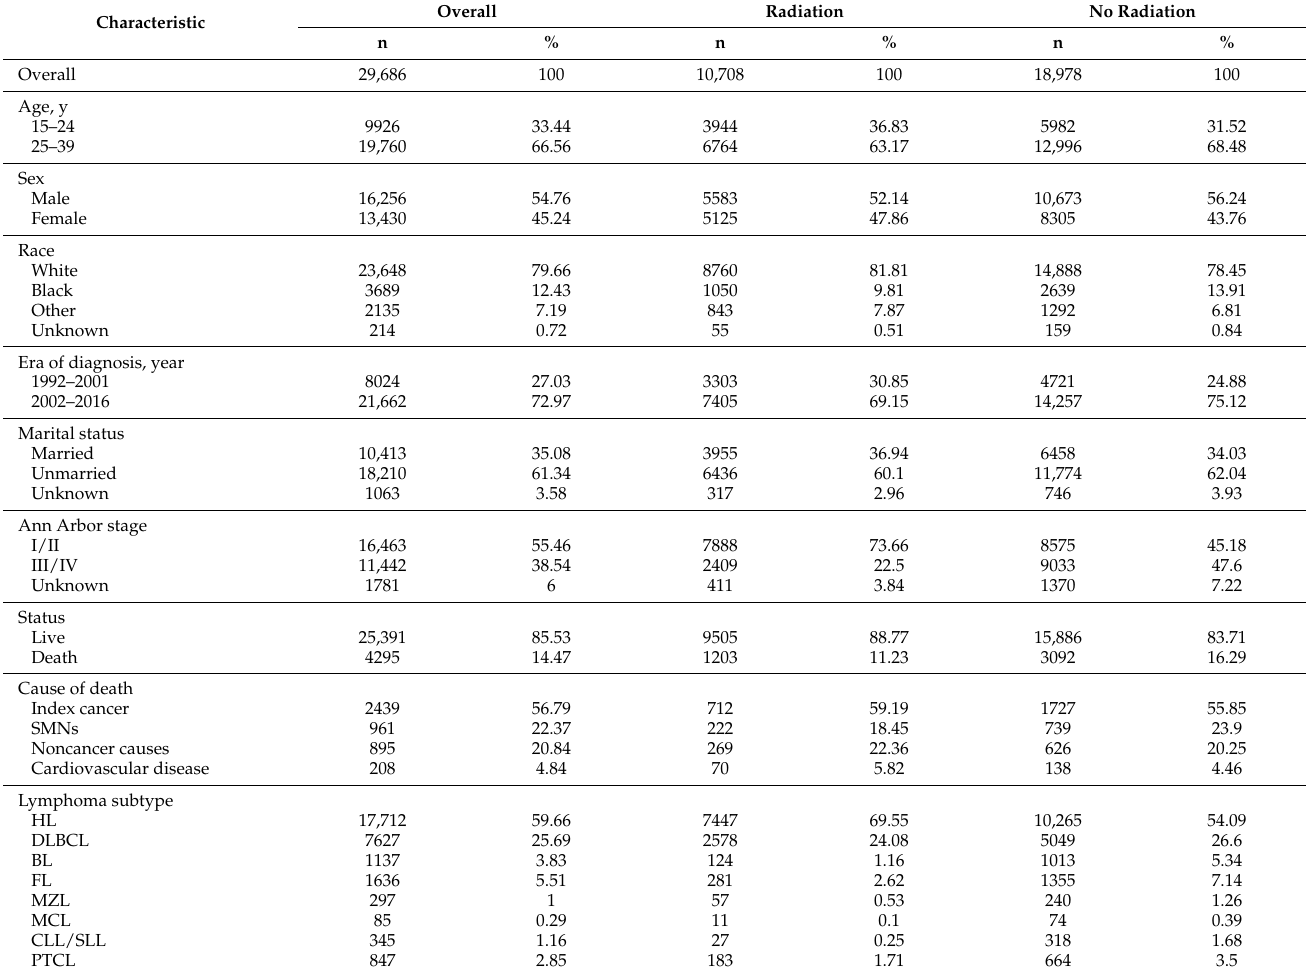
Table 1. Patient baseline demographic characteristics.